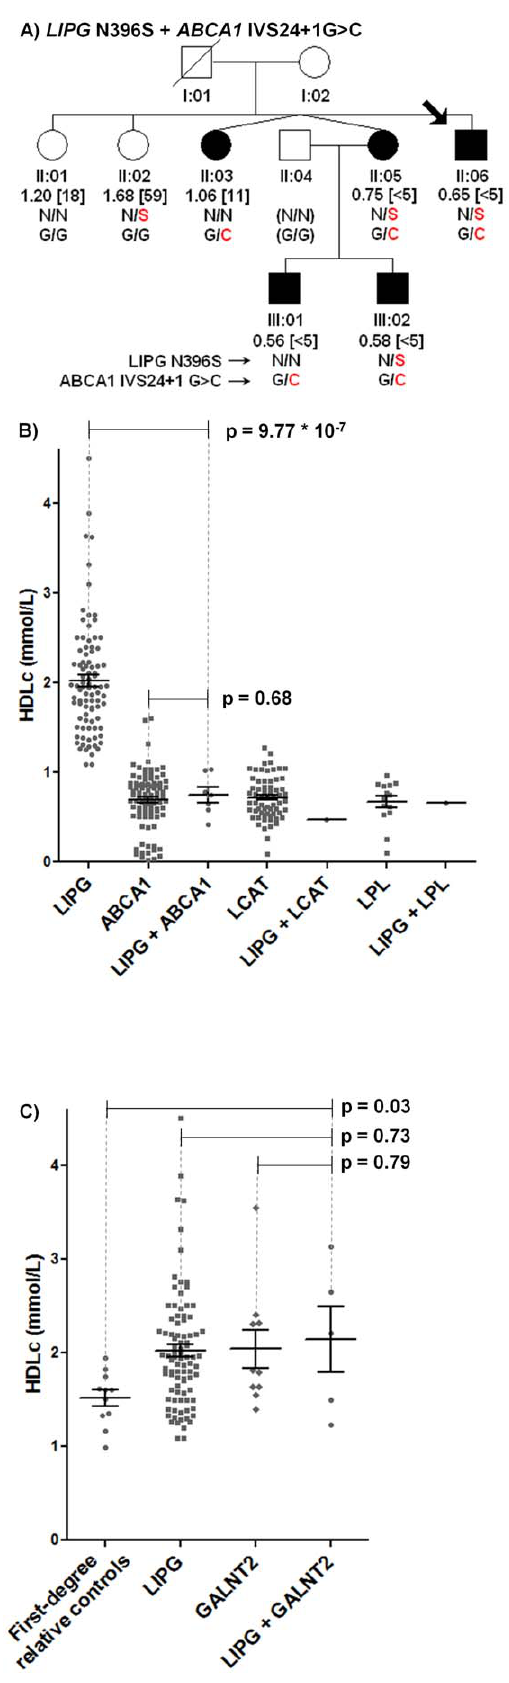
Figure 3. Characterization of probands and families with multiple mutations. A ) Representative segregation of LIPG N396S and ABCA1 IVS24 + 1G . C mutations. Filled shape, HDLc , 15 th percentile; empty shape, HDLc $ 15 th percentile. B ) HDLc levels of individuals with LIPG + / 2 ABCA1 , LCAT , or LPL mutations. Individuals with LIPG mutations alone are described in Table 4. Individuals with single ABCA1 , LCAT , and LPL mutations are from an independent Dutch-Caucasian population (Tables S1, S2, and S3 and data not shown). C ) HDLc levels of individuals with mutations in LIPG , GALNT2 , or LIPG + GALNT2 . Individuals with single LIPG or GALNT2 mutations are described in Table